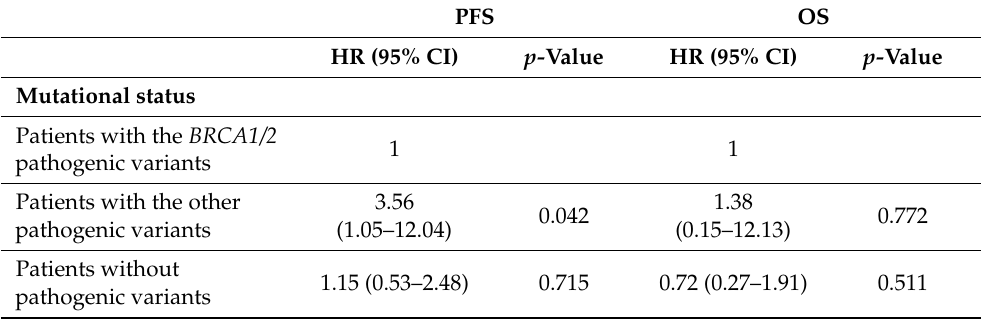
Table 4. Progression-free survival (PFS) and overall survival (OS) according to the mutational status. PFS OS